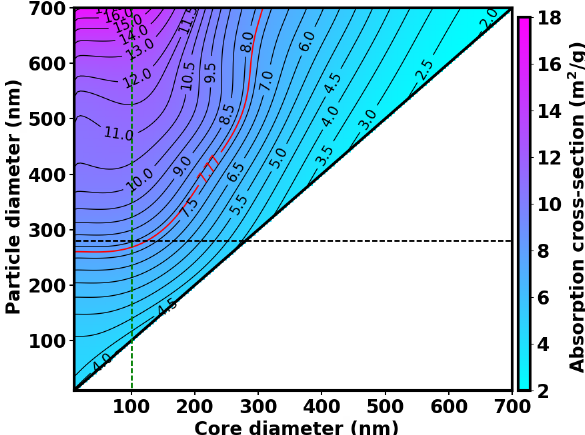
Figure 1. Variations in the MAC as a function of D BC and D particle calculated using the concentric core-shell Mie model at a wave- length of 880nm. The red solid line is the constant MAC value used in AE33. The bold black solid line is the 1 : 1 line that presents the variations in the MAC for pure BC particles with different D BC . The horizontal black dashed line distinguishes particles with a di- ameter of 280nm while the vertical green dashed line indicates a D BC of